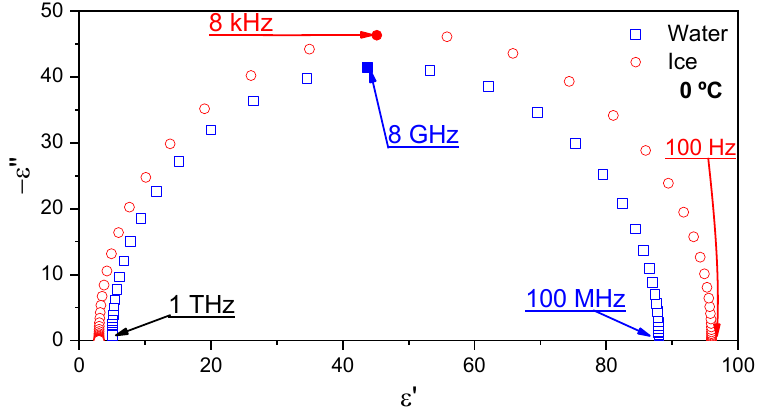
Figure 4. Cole–Cole plot showing the real, ε ’, and imaginary, ε ’’, parts of the dielectric permittivity of water and ice, both at 0 °C. Reconstructed from data in [35].